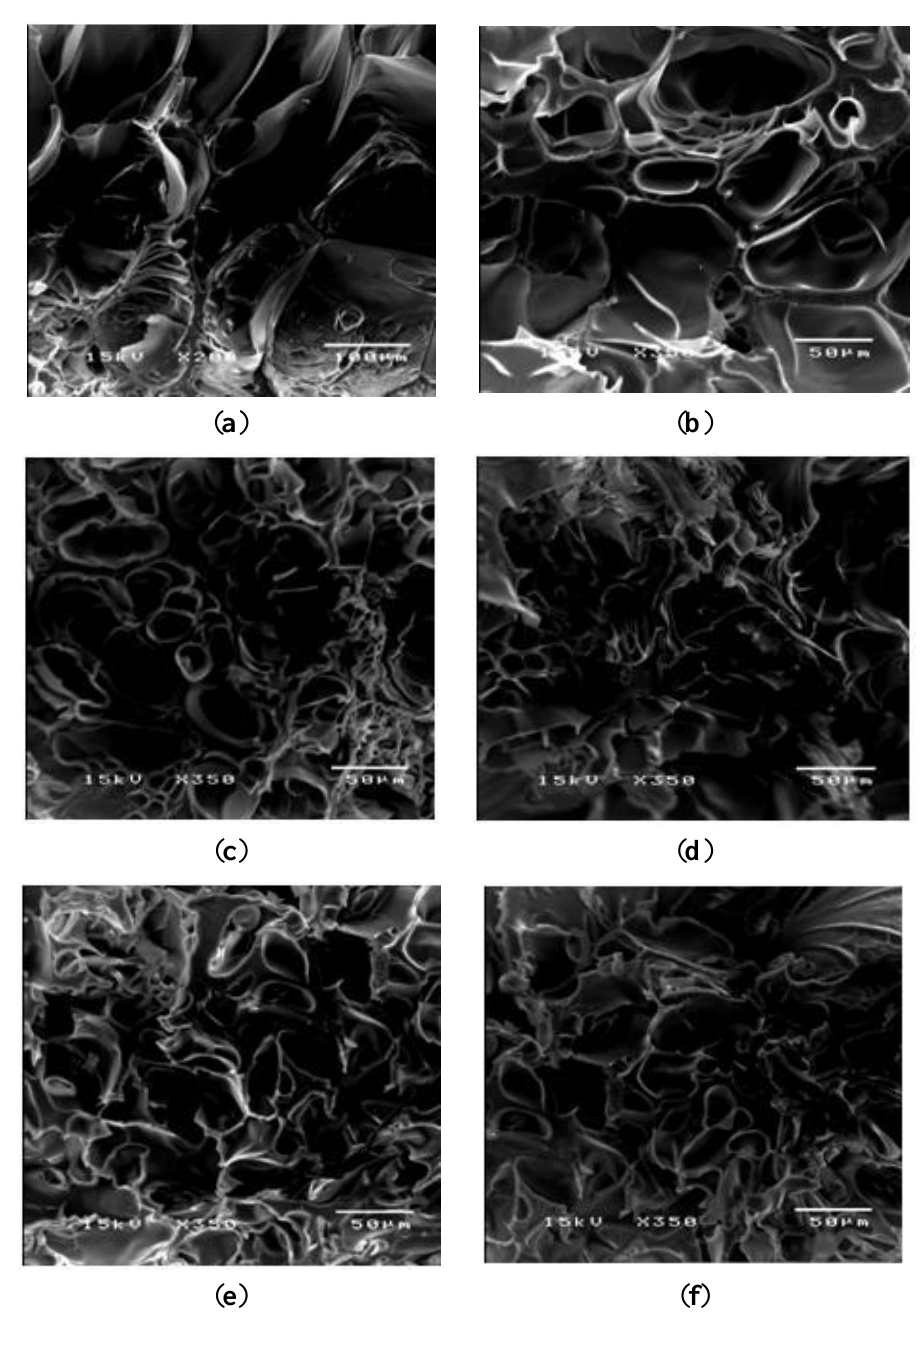
Figure 2. The morphology of PAAM hydrogel after swelling: ( a ) PAAM_1; ( b )